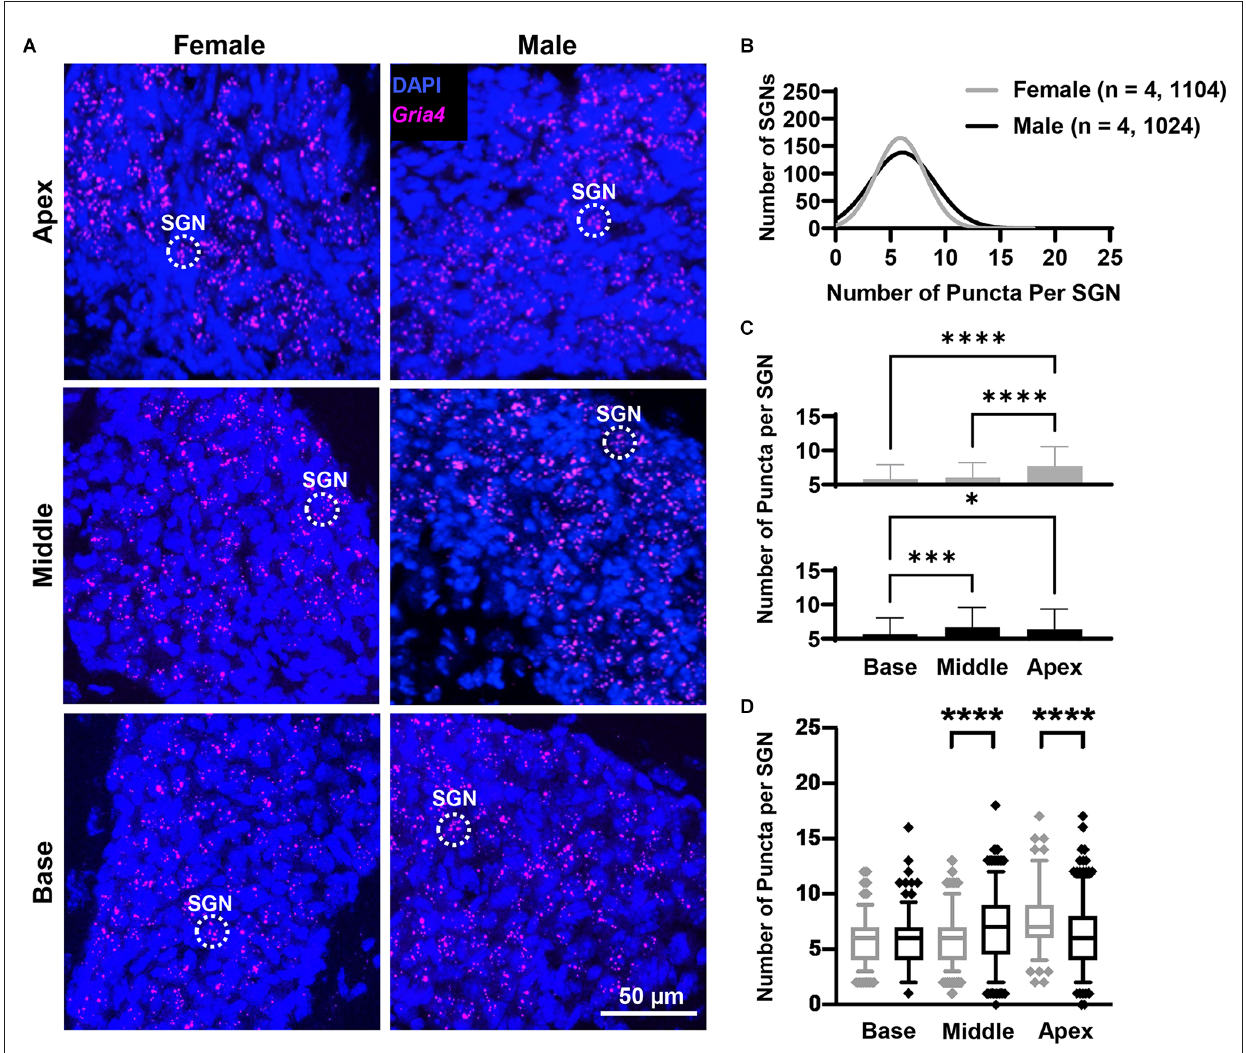
FIGURE5 Gria4 mRNA counts analyzed by cochlear region and sex. (A) Representative fluorescent confocal stack of images of Gria4 (false-colored in magenta) and DAPI (blue) in the base, middle, and apex cochlea turns for females and males. (B) Histogram representing the distribution of Gria4 mRNA counts in female (gray line) and male (black line) mice throughout the entire cochlea. Numbers in parentheses indicate the number of mice, followed by the total number of SGNs. (C) Bars show the mean Gria4 mRNA puncta on different cochlea turns on SGNs of female (gray bars, top) and male (black bars, bottom) mice. Error bars represent ± SD. (D) Whisker plots of Gria4 mRNA puncta on different cochlea turns on SGNs of females (gray) and males (black). Males had more Gria4 mRNA in the middle turn, while females had more Gria4 mRNA in the apex. Whiskers display the 5 and 95 percentiles. Samples consisted of the total number of SGNs for which Gria4 puncta were counted in females and males. See Table 2 for sample sizes by region. Independent samples t-test, ∗ p < 0.05, ∗∗∗ p < 0.0005, **** p < 0.0001, see “Results” Section for specific p -values.